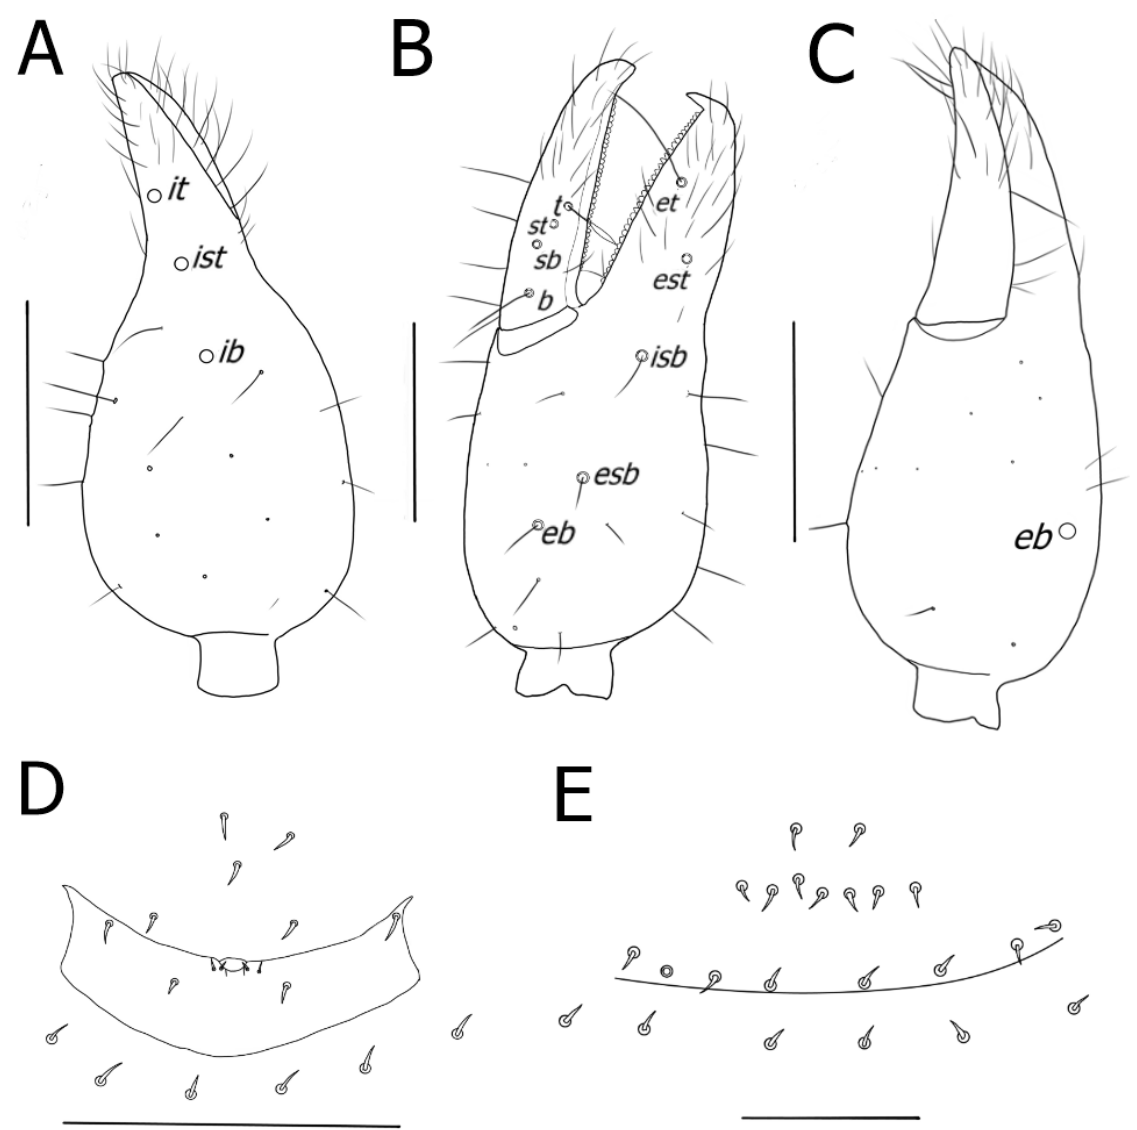
Fig. 13. Ideobisium sonqo sp. nov. A . Chela in dorsal view. B . Chela in retrolateral view. C . Chela in ventral view, showing trichobothria. D . Genital area. E . Genital area. A–D: holotype, ♂ (QCAZ); E: allotype, ♀ (QCAZ). Scale bars: A–C = 0.25 mm; D–E = 0.10